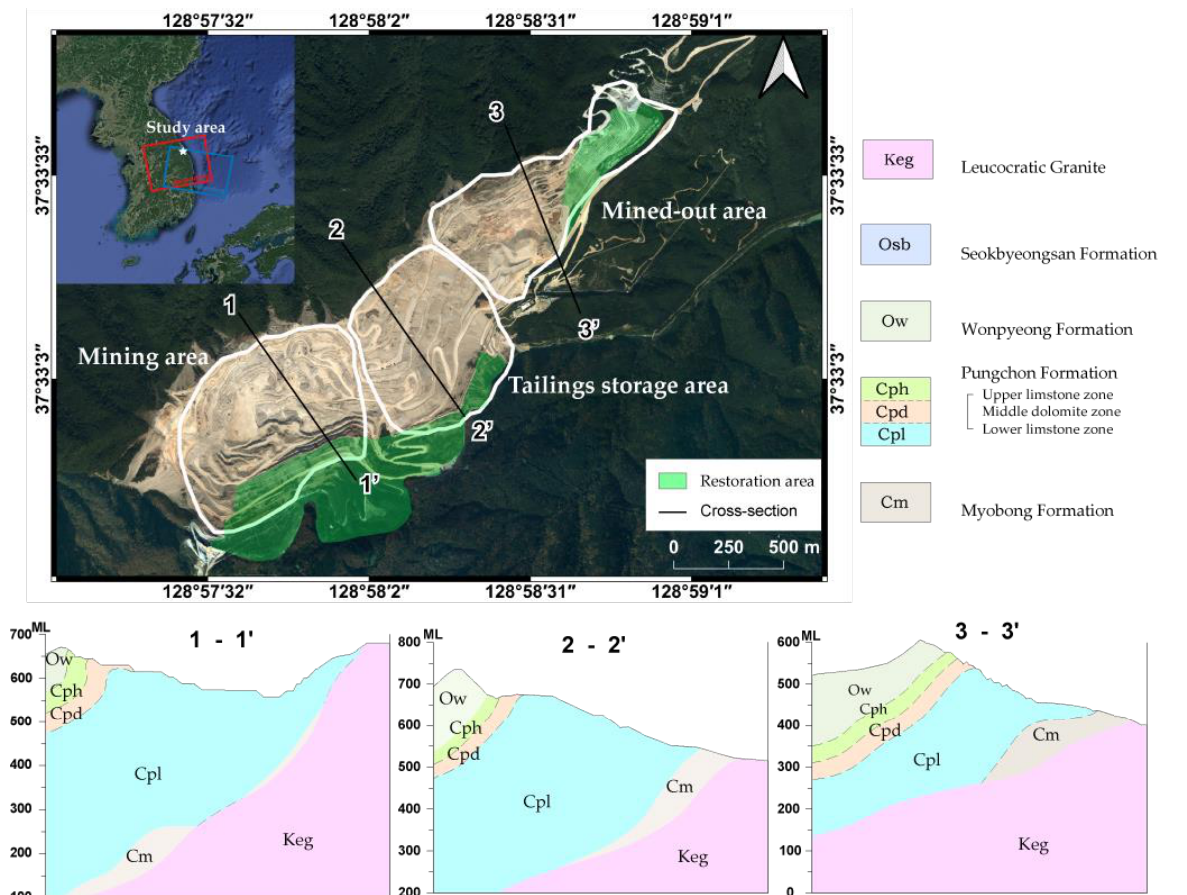
Figure 1. The study area is divided into the mining area, tailings storage area, and mined-out area. Geological profiles were drawn along the three lines. The red box represents the ascending pass of the Sentinel-1 SAR images, while the blue box is the descending pass. The background image is a satellite image from 2019 using Google Earth.